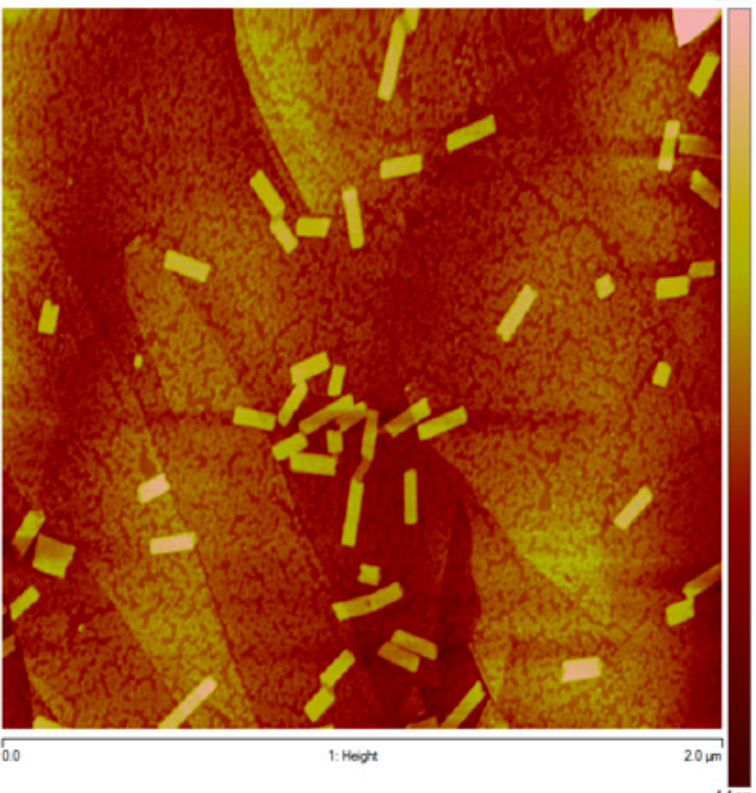
Figure 4. Peak force microscopy imaging of nanotubes of TPPS 3 ( 1 ) aggregates deposited on HOPG.